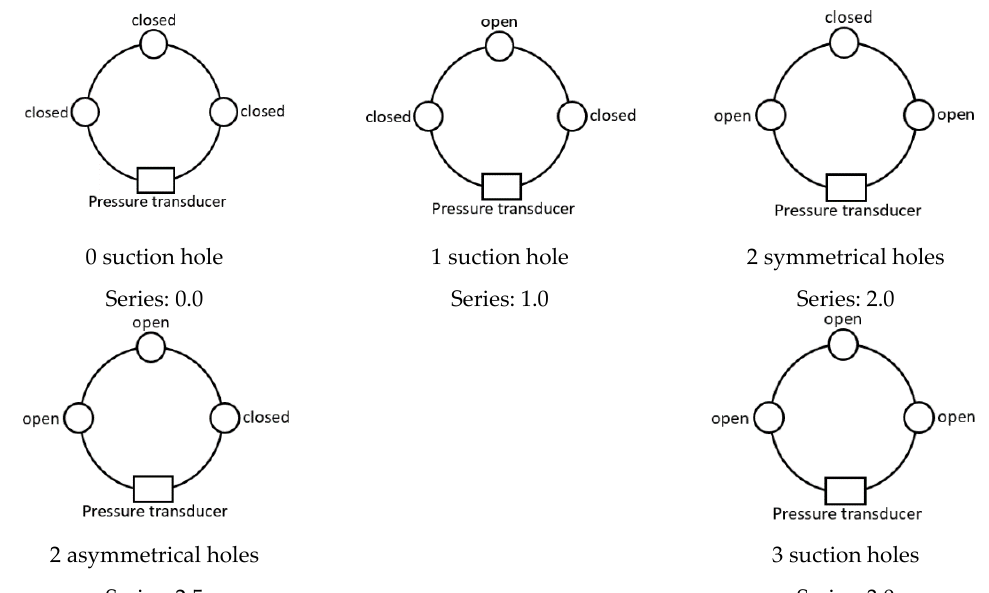
Figure 7. Description of suction hole distribution.